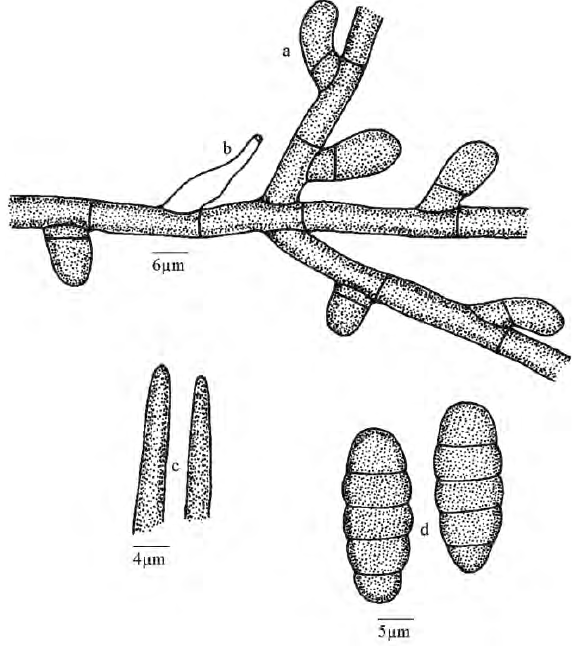
Figure 66. Meliola crescentiae a - Appressorium; b - Phialide; c - Apical portion of mycelial setae; d -